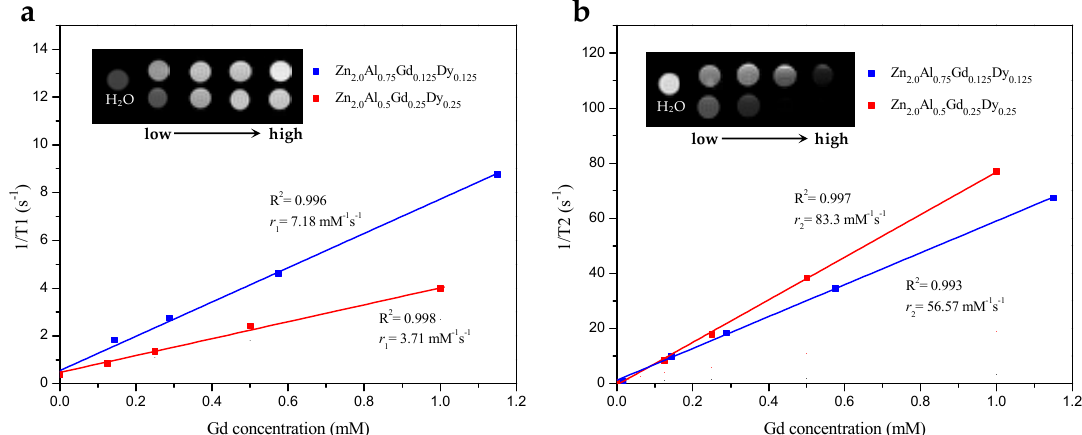
Figure 4. ( a ) T1- and ( b ) T2-relaxivity plots of aqueous suspensions of GdDy-LDHs with different Gd 3+ concentrations, and MRI images.